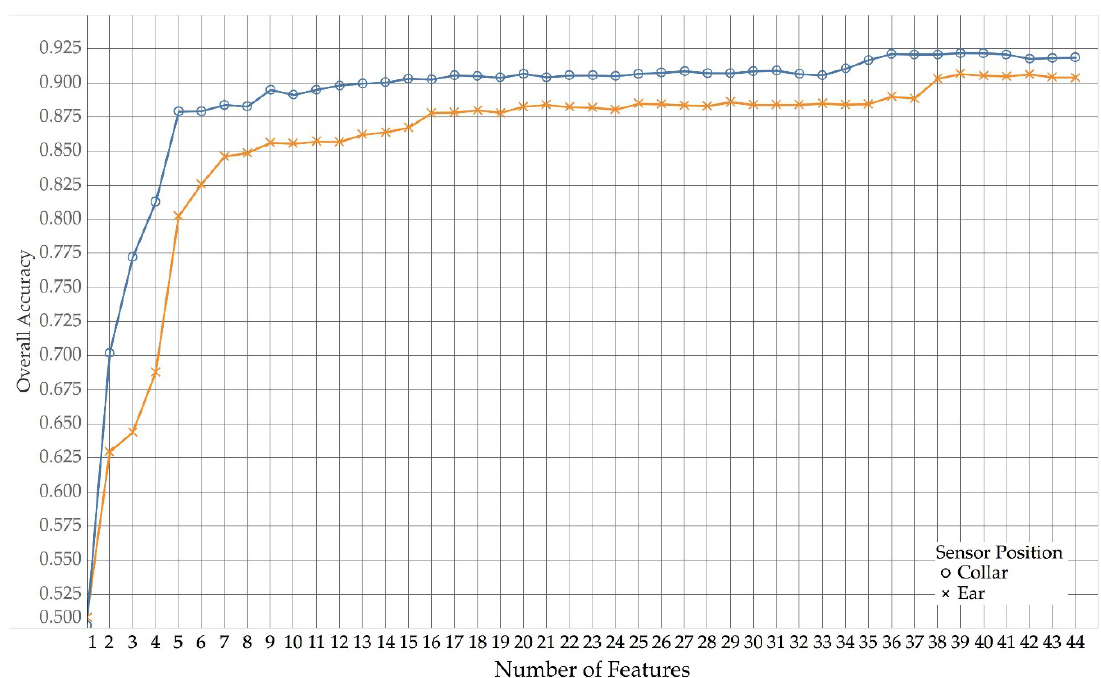
Figure 5. Overall accuracies for ear and collar data over number of features using Random Forest.